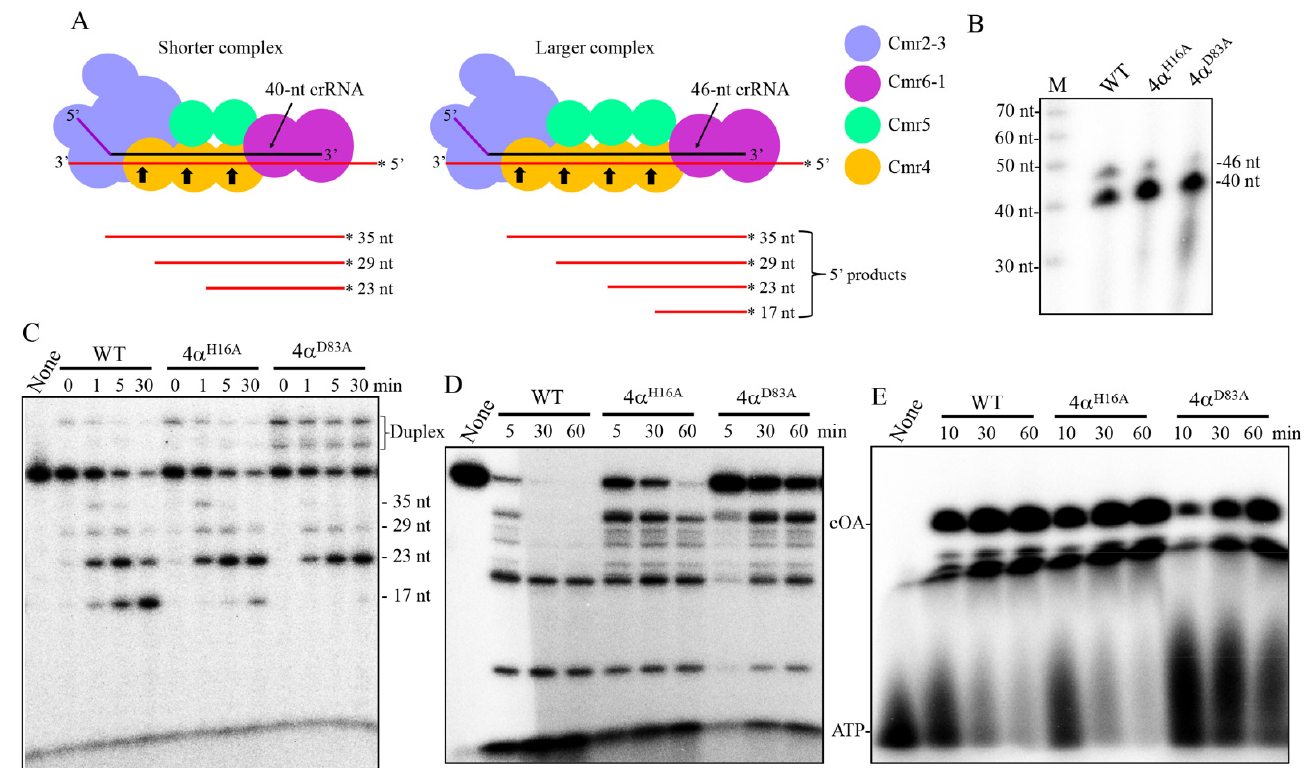
Figure 5. crRNA distribution pattern and activities of Cmr- α _4 α H16A and Cmr- α _4 α D83A . ( A ) Schematic map of the shorter (carrying a 40-nt crRNA and three Cmr4 subunits) and the longer (carrying a 46-nt crRNA and four Cmr4 subunits) Cmr- α complexes and their RNA cleavage products. Asterisk symbol at each RNA end indicates radio-labeling. ( B ) crRNA distributions of WT (wild-type Cmr- α ), 4 α H16A and 4 α D83A represent the Cmr- α effectors carrying the indicated Cmr4 α mutation (i.e., Cmr- α _4 α H16A and Cmr- α _4 α D83A ). Activities of the three Cmr- α complexes: tgRNA cleavage ( C ), ssDNA cleavage ( D ) and cOA synthesis ( E ). Cleavage assay was conducted for the time periods indicated in the figures; smaller fragments in panel C and D panels represent cleavage products. The sizes of RNA cleavage products in 6-nt periodicity are indicated. None: substrate only, no Cmr complex was added; duplex: duplex of crRNA and substrate; cOA: cyclic oligoadenylates.